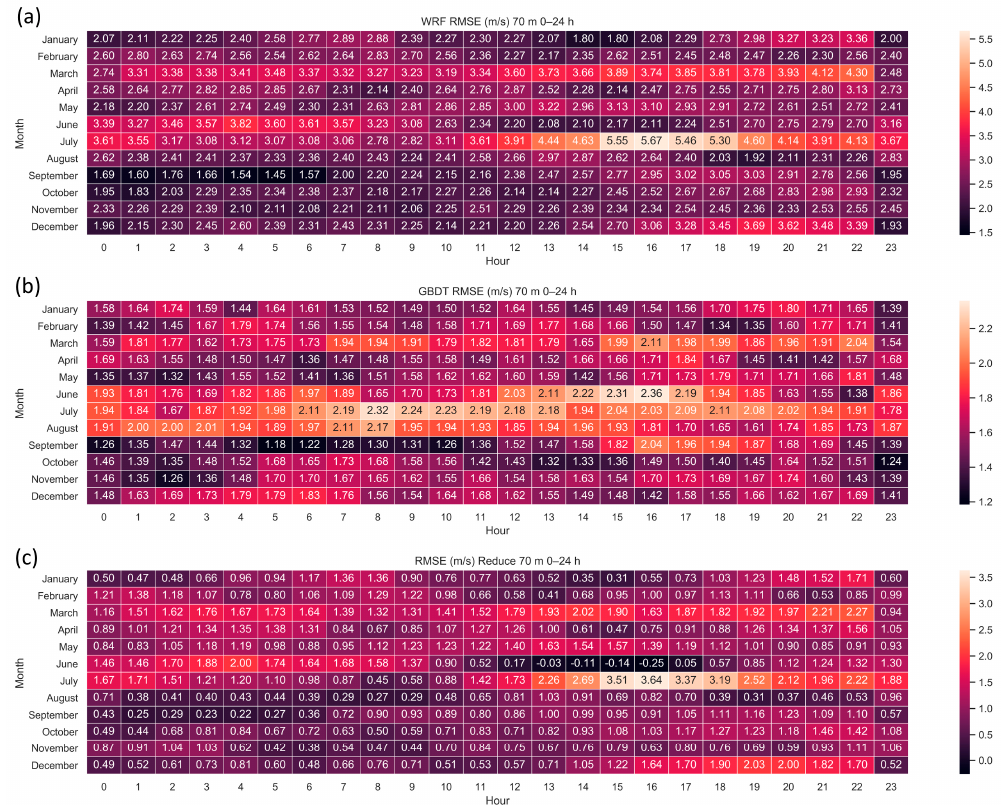
Figure 12. RMSE results of 14 towers in different month and different hour, ( a ) the WRF results, ( b ) the GBDT results, and ( c ) the reduced value of GBDT relative to WRF results.